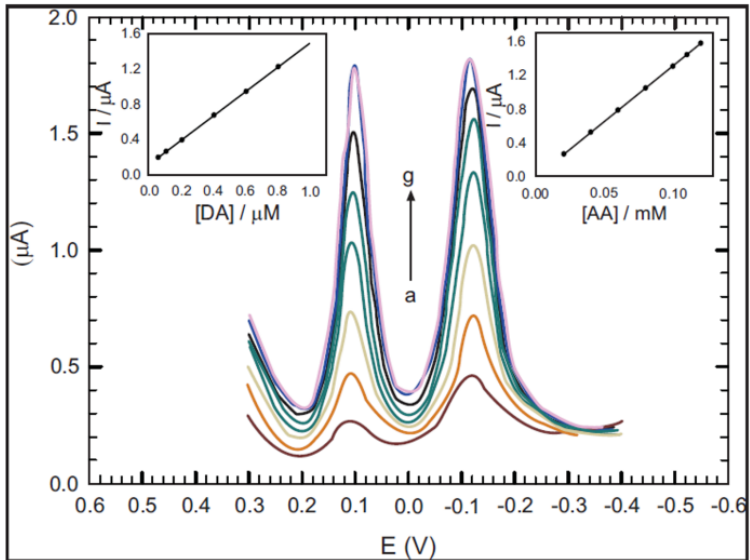
Figure 30. Differential pulse voltammetry measurements (DPVs) obtained during the simultaneous change of AA and DA at Pt/PMT(BE)/Pd(CV) in PBS, pH 7.4. DA contents (from a to g): 0.05, 0.1, 0.2, 0.4, 0.6, 0.8, and 1.0 μ M. AA contents (from a to g): 0.02,